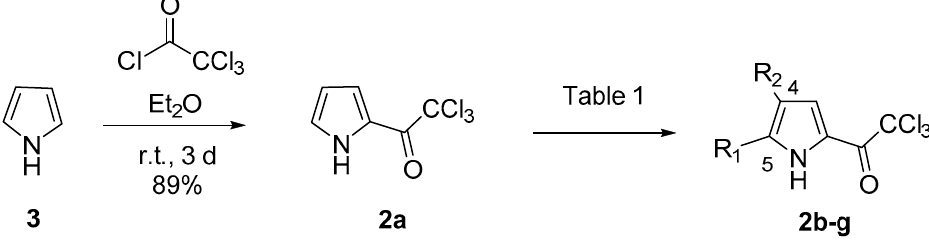
Table 1. Reaction conditions and outcomes for the synthesis of halogenated pyrroles 2b – g . Conditions